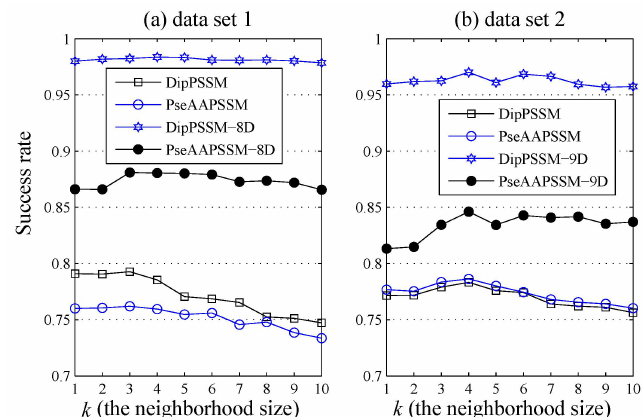
Figure 7. Comparison of success rates among different k values by DipPSSM, PseAAPSSM, DipPSSM with LDA and PseAAPSSM with LDA, respectively: ( a ) Dataset 1 and ( b ) Dataset